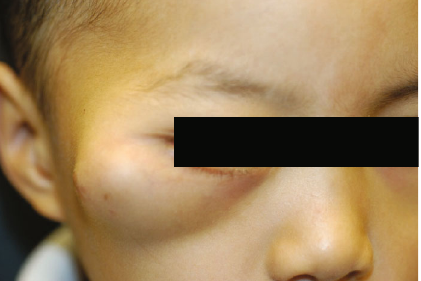
Figure 2: External photograph of patient ’ s right facial mass involving the lateral